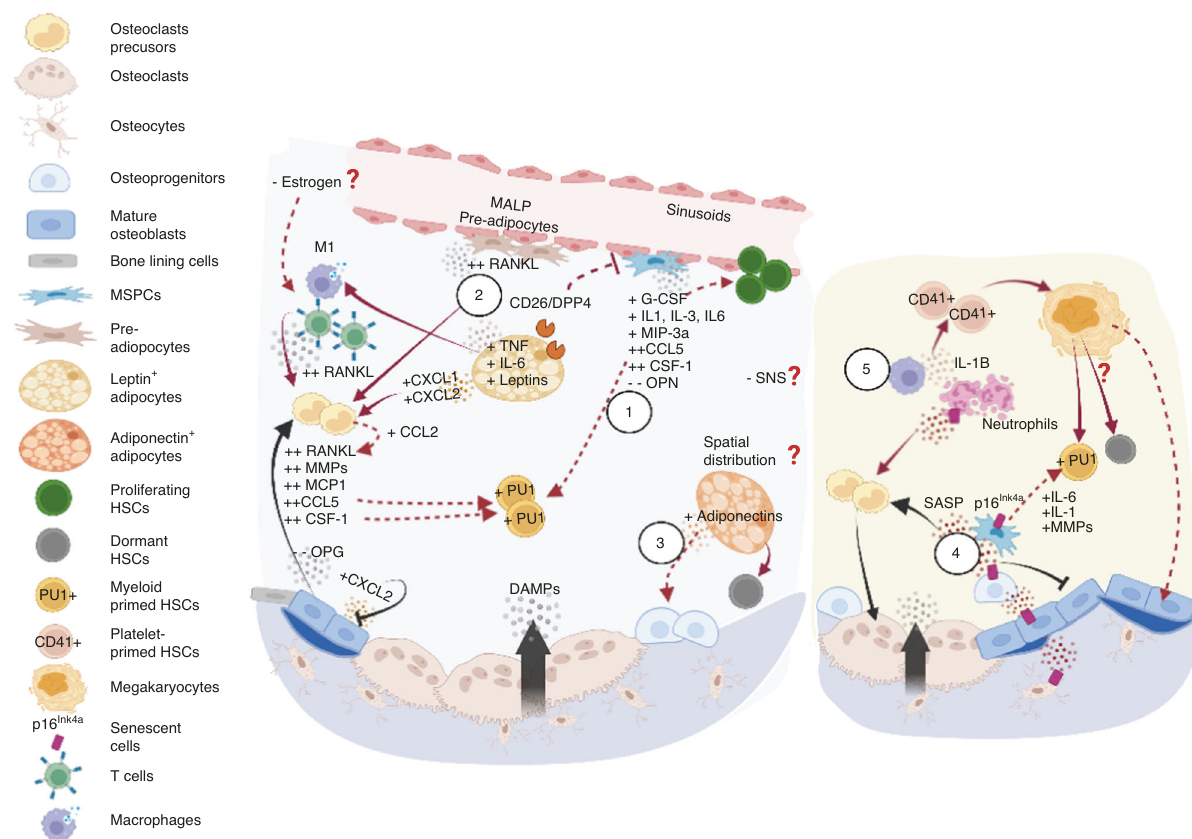
Fig. 4 Skeletal aging and its impact on the hematopoietic compartment. Aging of osteolineage cells leads to an overall in fl ammatory microenvironment (left panel) and acquisition of the senescence-associated secretory phenotype (SASP, right panel). (Left 1) In general, aged osteoprogenitors employ a myeloid-promoting program, attributed to telomere dysfunction that manifests as upregulation of G-CSF, IL-3, MIP-3a levels in bone-associated stromal cells, and aging of bone cells that overexpress CSF-1, IL-1, CCL5, etc. (2) Aged MSPCs are also primed for adipocyte differentiation, synergistically promoting myelopoiesis. Speci fi cally, the preadipocyte (Pref-1 + or MALP) population is expanded with upregulated RANKL expression. Adipocytes further secrete leptins, DPP4, IL-6, TNF, and CXCL1/CXCL2 to promote osteoclastogenesis while inhibiting osteodifferentiation, which promotes the proin fl ammatory immune phenotype. (3) In contrast, adiponectins promote osteoprogenitors and have been shown to protect HSCs from in fl ammatory insult and enhance self-renewal. Hypothetically, leptin- and adiponectin-secreting adipocytes exhibit spatial associations with bone resorption and formation sites, respectively, and may contribute to differential HSC responses. (Right 4) Multiple cell types, including osteoblasts, osteoprogenitors, osteocytes, lymphocytes, and myeloid cells, undergo senescence and are associated with the overproduction of IL-6, IL-1, MMPs and other proin fl ammatory cytokines that promote bone resorption and myeloid bias. (5) Reduced phagocytic capability of macrophages leads to the accumulation of senescent neutrophils, an increase in IL-1 level and induced platelet bias. Whether increased megakaryopoiesis causes myeloid bias and HSC accumulation remains unclear. Overall, aging is associated with contraction of Type H vessels, and arterioles, depleting niche factors that support lymphopoiesis and possibly negatively impacting the SNS. Although important, it remains unclear whether effects of estrogen de fi ciency on bone remodeling kinetics cause substantial variability in aged HSC niches between (LSK) compartment. 132,133 With a positive regulatory effect, not only act on skeletal stem cells to shift their fate to adipogenesis under a diet-based stimulation 130 but also enhance adipocytes in long bones has been shown to promote the regeneration of HSCs via increased SCF secretion after exposure to proin fl ammatory programs, such as the secretion of IL-6 from radiation-induced stress. 92 Interestingly, Meacham et al. demon- monocytes, chemokines from macrophages, and Thy1 from polarized CD4 + T cells. Adipocytes have also been shown to strated a role for adiponectin in maintaining HSC self-renewal switch macrophages to the proin fl ammatory phenotype in obese throughout aging and protecting HSCs from insults caused by mice. 131 In contrast, adiponectins play roles in guiding the in fl ammatory cytokines. 134 Notably, these effects were speci fi c to migration and differentiation of osteoprogenitors (Fig. 4.3) to HSCs and less prominent in differentiated cells. resorptive regions or sites of microdamage. 128 In other words, the Overall, these studies suggest that adipocytes regulate hematopoiesis through both direct and indirect mechanisms. adipocyte population can regulate hematopoiesis through the Given the positive role of adiponectins in bone formation, one microenvironment and potentially through bone remodeling. can postulate that osteogenic sites may exhibit a high local Adipocytes also impact hematopoiesis directly in numerous concentration of adiponectins that may favor HSC self-renewal. ways; however, whether they play bene fi cial or detrimental roles Future work is required to better understand whether bone remains controversial in part due to the different effects they exert marrow cavities that undergo different stages of bone remodel- on stem or progenitor cells and differences in the locations of the ing harbor functionally different adipocytic subsets and how this adipose tissue. For example, depleting adipocytes in fat-enriched variability modulates in fl ammatory responses, hematopoietic tail vertebrae increased the expansion of progenitor cells after recovery, and HSC self-renewal. irradiation, while this effect was less prominent in the stem cell